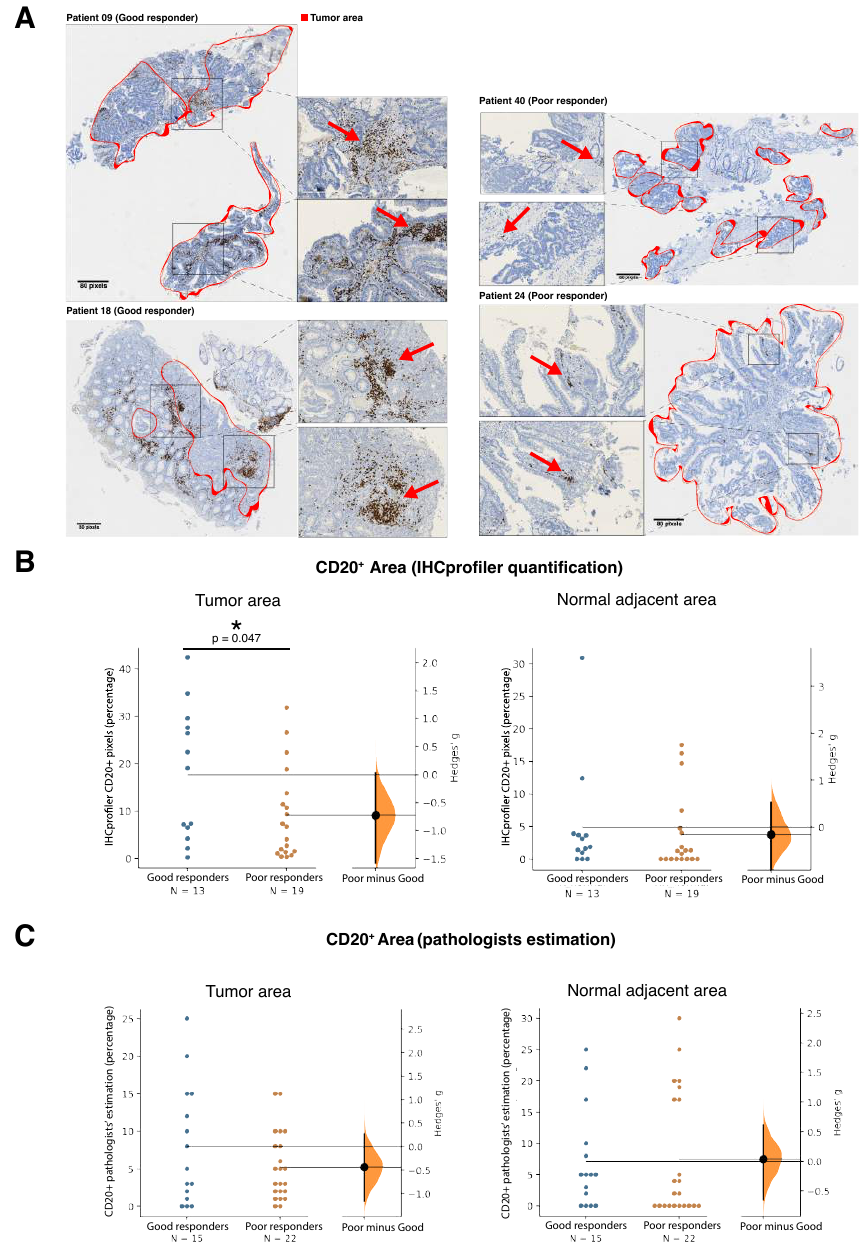
Figure 3. Validation of differential density of B cells in good and poor responders in the LARC cohort by anti-CD20 immunohistochemistry using slides obtained from the FFPE mirror image of the same pre-treatment tumor biopsies that were used for molecular analysis (see Methods). ( a ) H&E section images with CD20 staining for representative good (patients 09 and 18) and poor (patients 24 and 40) responders. Scale bars correspond to 80 pixels. Tumor areas are delimited with red lines, and the remaining areas are considered normal peritumoral tissue. Zoom sections of each scanned image correspond to a 10X magnification, with CD20 positive cells indicated with arrowheads. ( b , c ) Gardner-Altman estimation plots showing the distribution of the abundance of CD20 positive cells according to a digital quantification of stained areas (IHCprofiler; ( b ) and the pathologists’ evaluation ( c ), both in tumor and normal areas. The significance of the differences was tested by Mann-Whitney U test (* p < 0.05). Differences between ( b ) and ( c ) in the number of patients correspond to availability of FFPE samples and/or digital